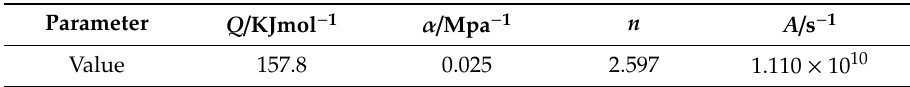
Table 1. Material constants and deformation activation energy ( Q ) of nanohybrid / AZ80 composites in the constitutive